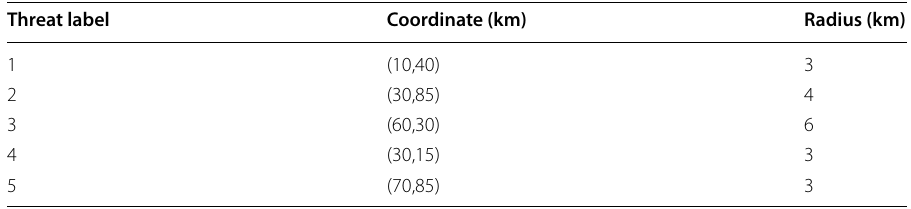
Table 2 Threat information Threat